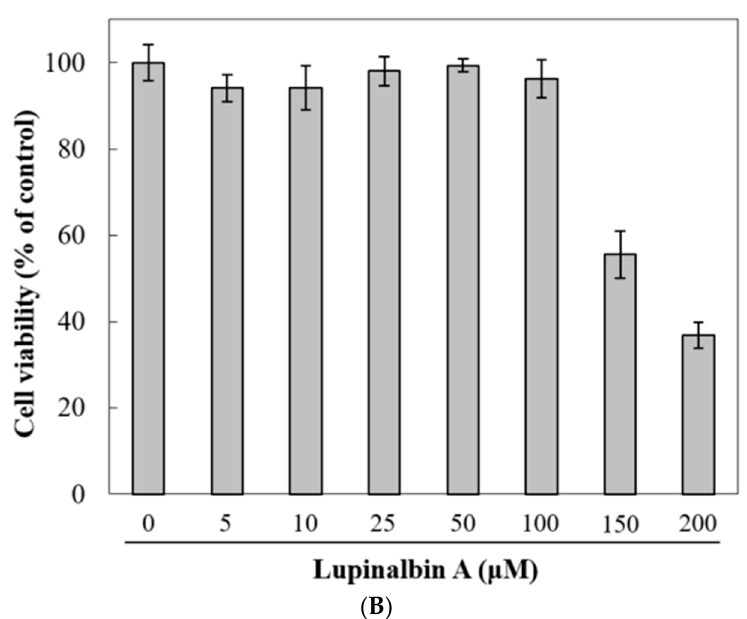
Figure 1. Chemical structure of lupinalbin A and effect of lupinalbin A on cell viability in RAW264.7 cells. ( A ) The chemical structure of lupinalbin A; ( B ) Cell viability was measured by EZ-Cytox cell viability assay. Cells were treated with various concentrations of lupinalbin A (5–200 µM) for 24 h. The data are presented as mean ± SDs ( n = 6).